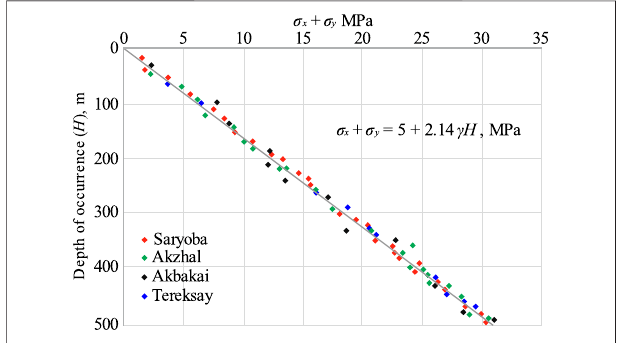
FIGURE7| Changeinthesumofhorizontalstresses( σ x + σ u